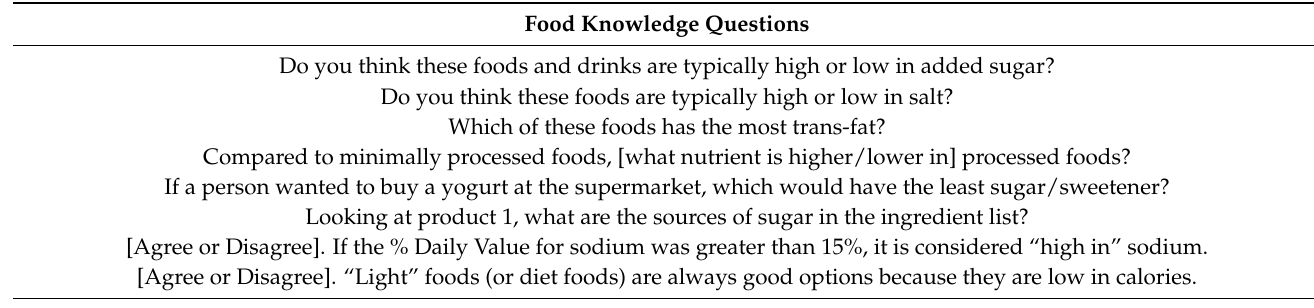
Table 1. Knowledge Survey Questions Coded as Food or Nutrition Knowledge. Food Knowledge